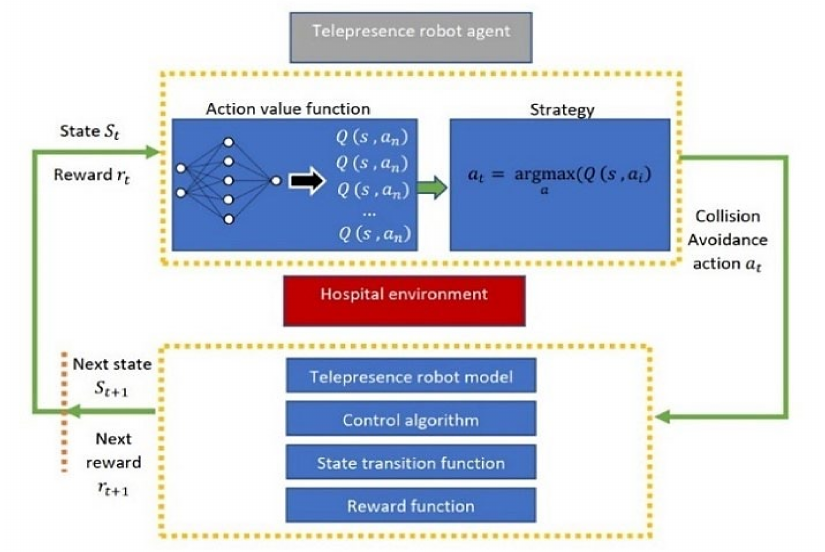
Figure 10. Proposed approach to control telepresence robot in assistance with human teleoperator.